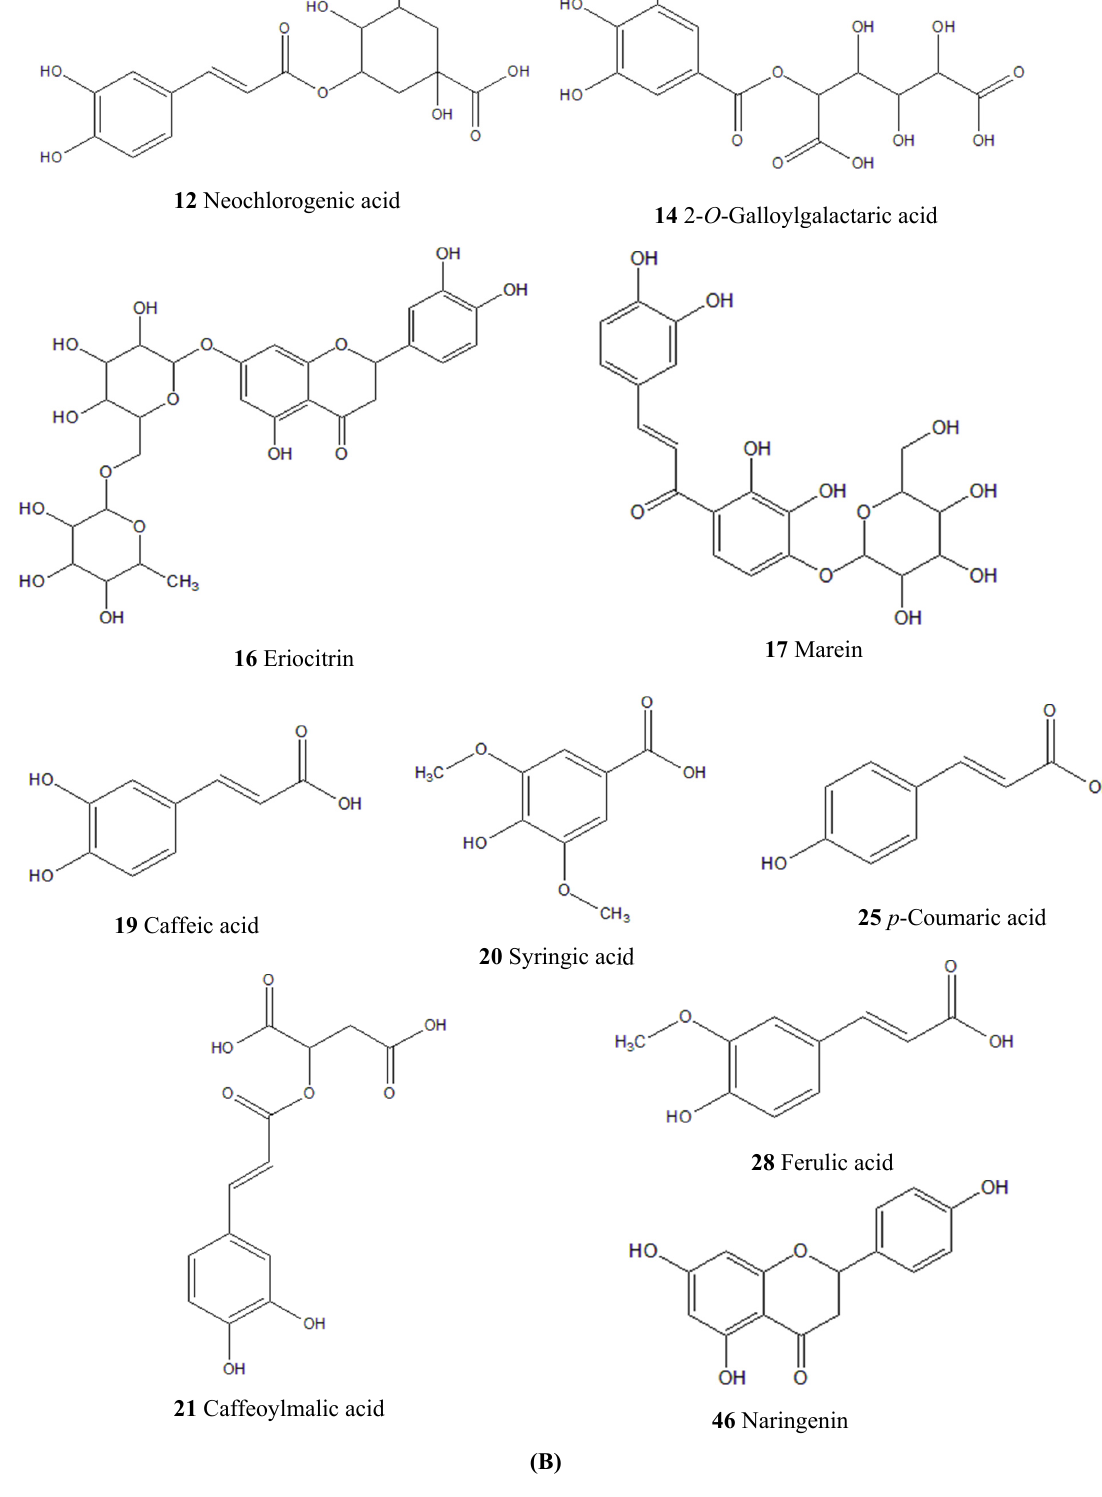
Figure 2. Chemical structures of constituents identified in Lysimachiae Herba: ( A ) general structures; ( B ) exact structures.